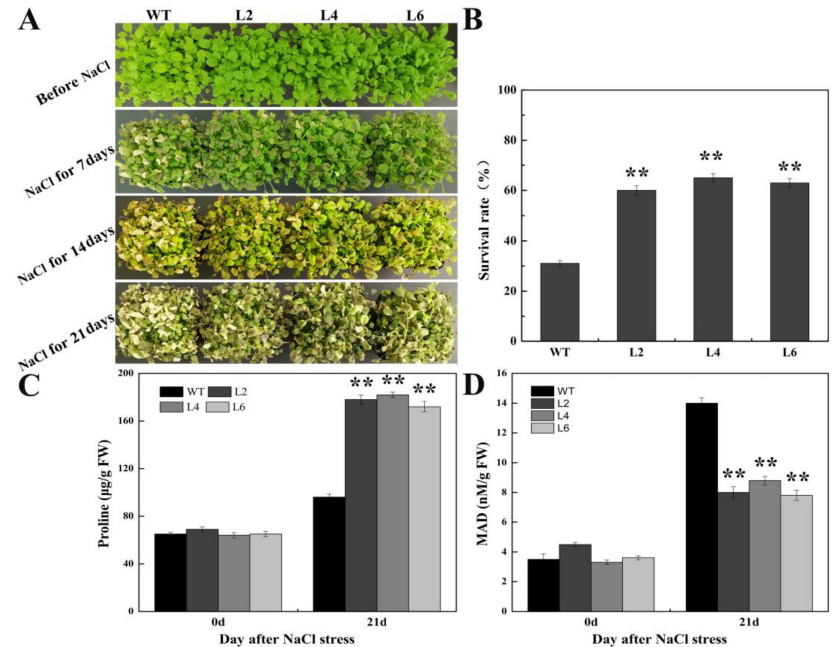
Figure 6. Photographs showing a comparison of the salt tolerance between transgenic and WT plants. ( A ) E ff ects of drought on the phenotypes of the L2, L4, L6 and WT plants. ( B ) The survival rate was calculated 7 days after rehydration. ( C ) Proline content. ( D ) MDA content. Error bars represent ± SD, and each value represents the averages of three repeated measures. ** indicate the significant di ff erences between the L2 / L4 / L6 plants and the WT plants ( p < 0.01).